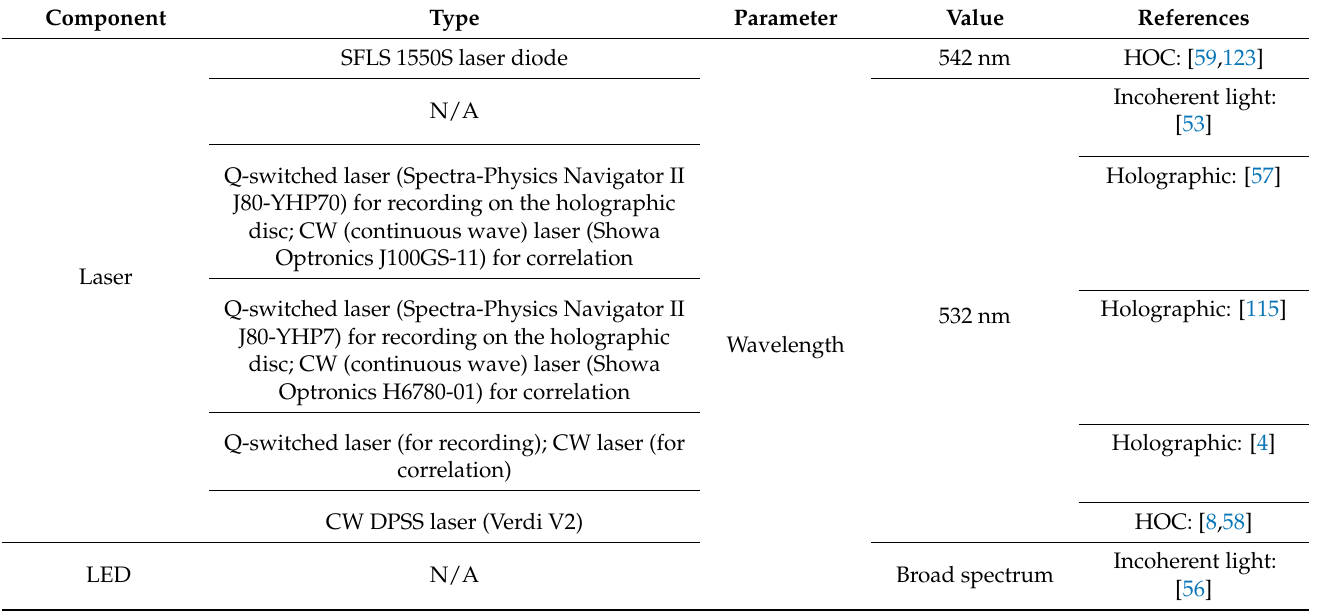
Table 8. Comparison between the most important parameters of the optical correlator setup in various proposed architectures, other than the JTC and